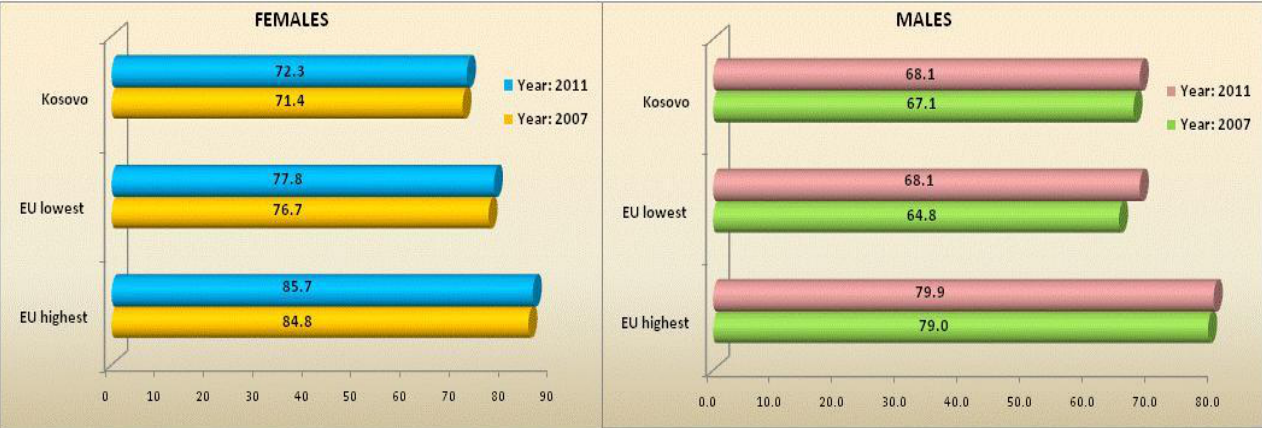
Figure 1. Life expectancy in Kosovo vis-à-vis the European Union in 2011 and in 2007 (just before the